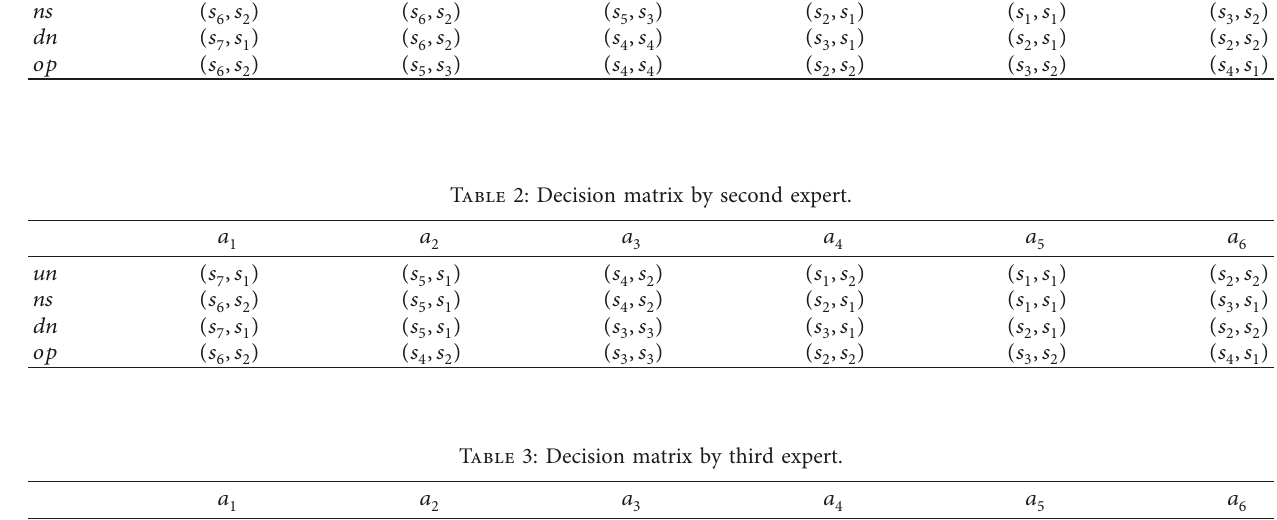
Table 3: Decision matrix by third expert.